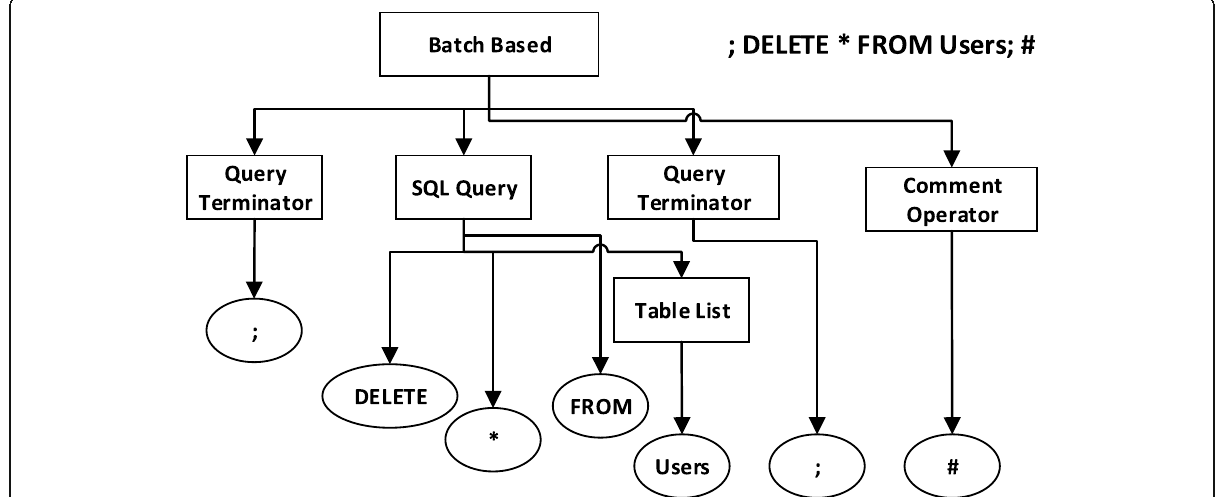
Fig. 4 Parse tree to depict SQL injection attacks using batch query. (ii). Like-based injection